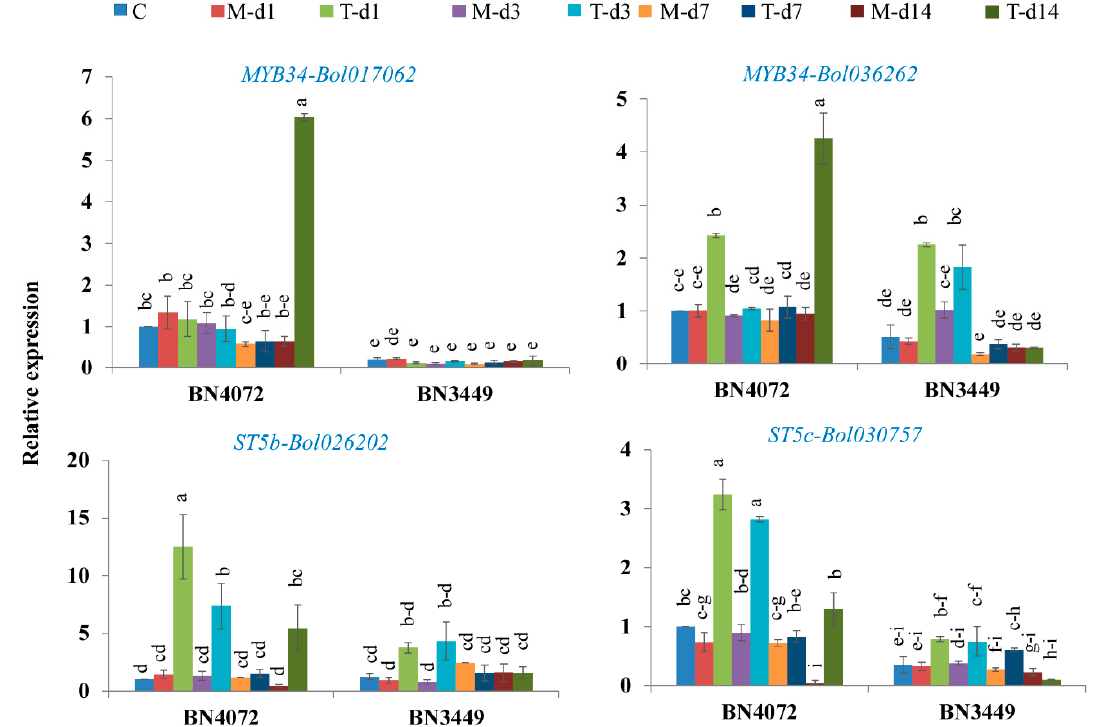
Figure 3. Remarkable upregulation of MYB34-Bol017062 , MYB34-Bol036262 , ST5b-Bol026202 , and ST5c-Bol030757 genes in Ringspot R line BN4072 at 14 DAI compared to mock-treated plants. C: